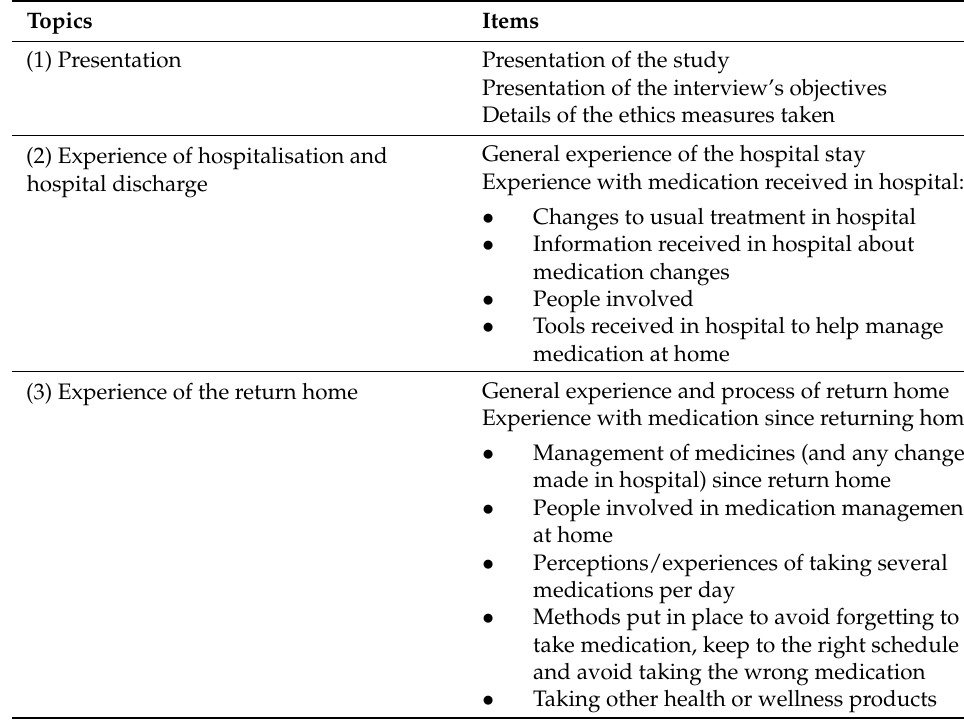
Table A1. Interview guide 1 with the older